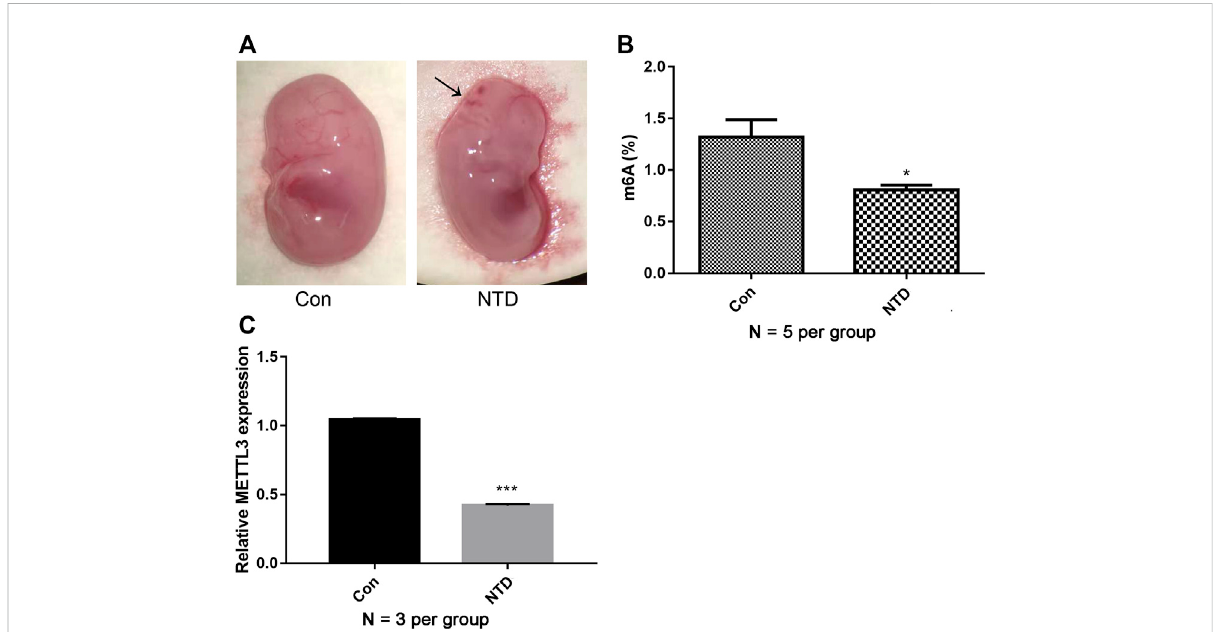
FIGURE 1 m 6 A levels and METTL3 expression were decreased in NTDs. (A) The dissecting microscope images for embryo in the control group and NTD groups on E16.5d. Arrows indicated the site of defects. (B) A quantitative m 6 A analysis was conducted to explore m 6 A enrichment in the brain